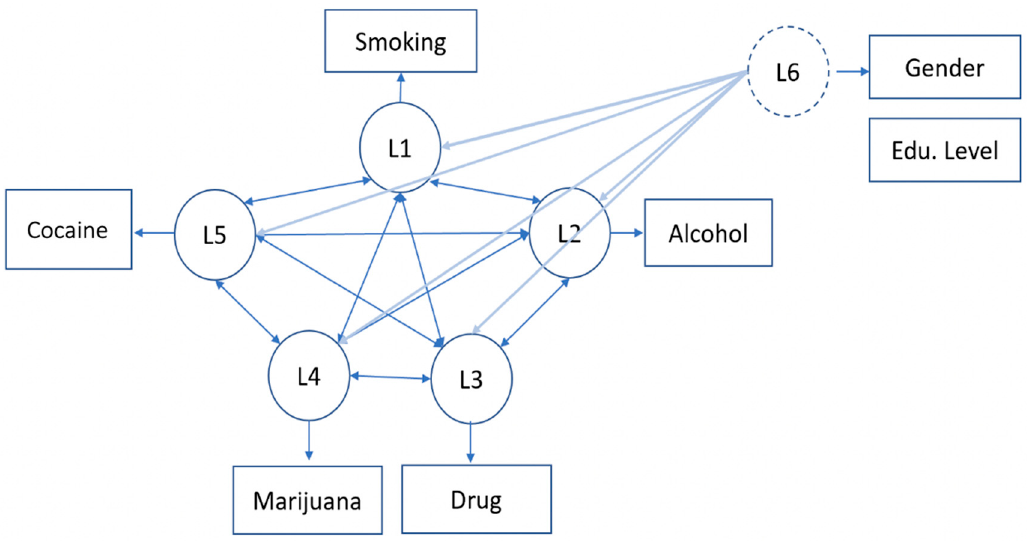
Figure 2. A path diagram used for the GSCA model with the gender covariate (Model 2). L1-L6 are the latent trait for Smoking, Alcohol, Drug, Marijuana, Cocaine, and Gender. L1-L5 are associated with each other phantom constructs, and the effect of the gender to the other five indicators are represented by the paths from L6 to L1–L5.